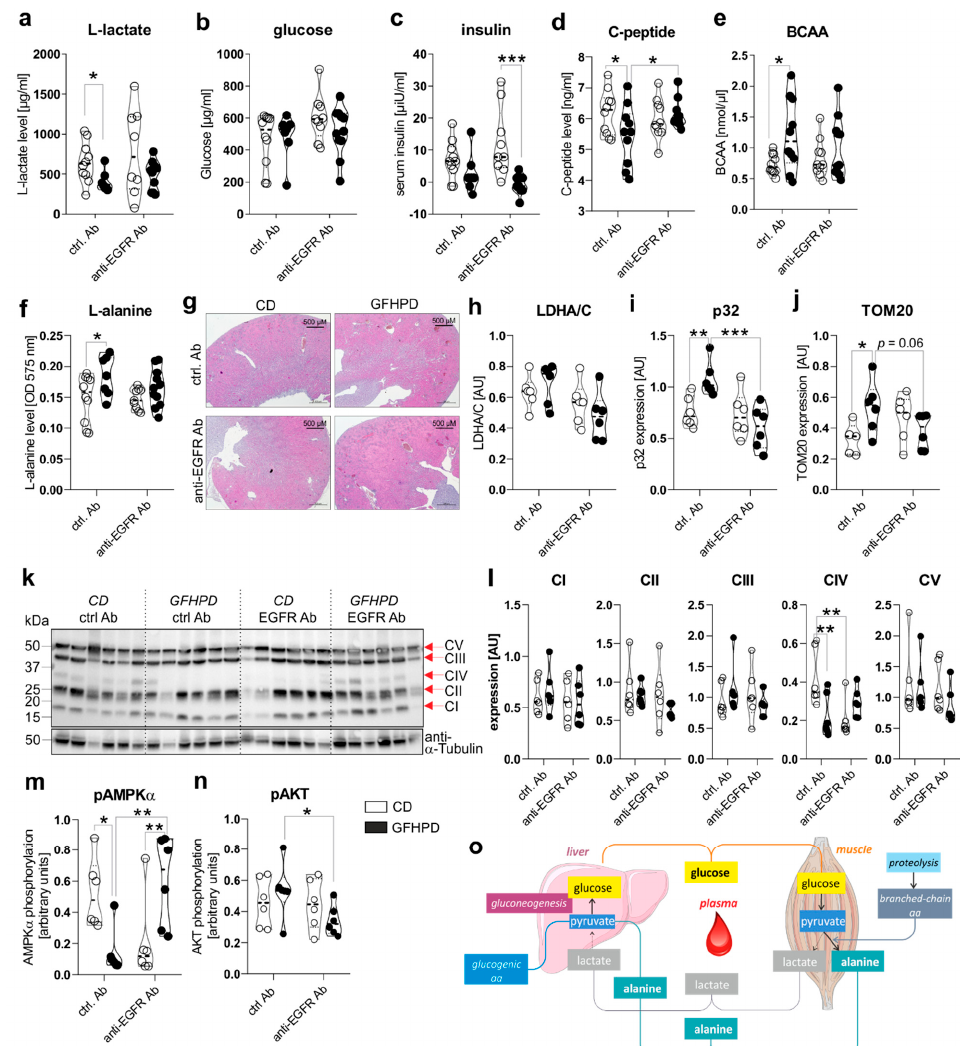
Figure 3. GFHPD application induces a metabolic shift from glycolysis towards amino acid metabolism and reduces colonic energy supply in AOM/DSS-treated mice. ( a – f ) Serum samples collected from indicated treatment groups at day 126 were analyzed with regard to ( a ) L-lactate, ( b ) D-glucose, ( c ) insulin, ( d ) C-peptide, ( e ) branched-chain amino acids (BCAA), or ( f ) L-alanine. ctrl. Ab ( n = 10 CD; n = 7–10 GFHPD), anti-EGFR Ab ( n = 8–10 CD; n = 9–11 GFHPD). ( g ) Representative images of HE-stained kidney tissue collected at day 126 from indicated treatment groups of AOM/DSS tumor mice. Original magnification, 2.5 × . ( h – n ) Protein expression of ( h ) LDHA/C, ( i ) p32, ( j ) TOM20, ( k , l ) OXPHOS complexes I–V, ( m ) phosphorylated AMPK α , ( n ) phosphorylated AKT, or α -Tubulin was determined by Western blot experiments utilizing biopsy samples collected from colorectal tumors ( n = 6 per group) of indicated treatment groups at day 126. Densitometric analysis was performed using ImageJ software and data were normalized to α -Tubulin values. ( o ) Schematic overview of systemic amino acid metabolism. * p ≤ 0.05, ** p ≤ 0.01. *** p ≤ 0.001. AU = arbitrary